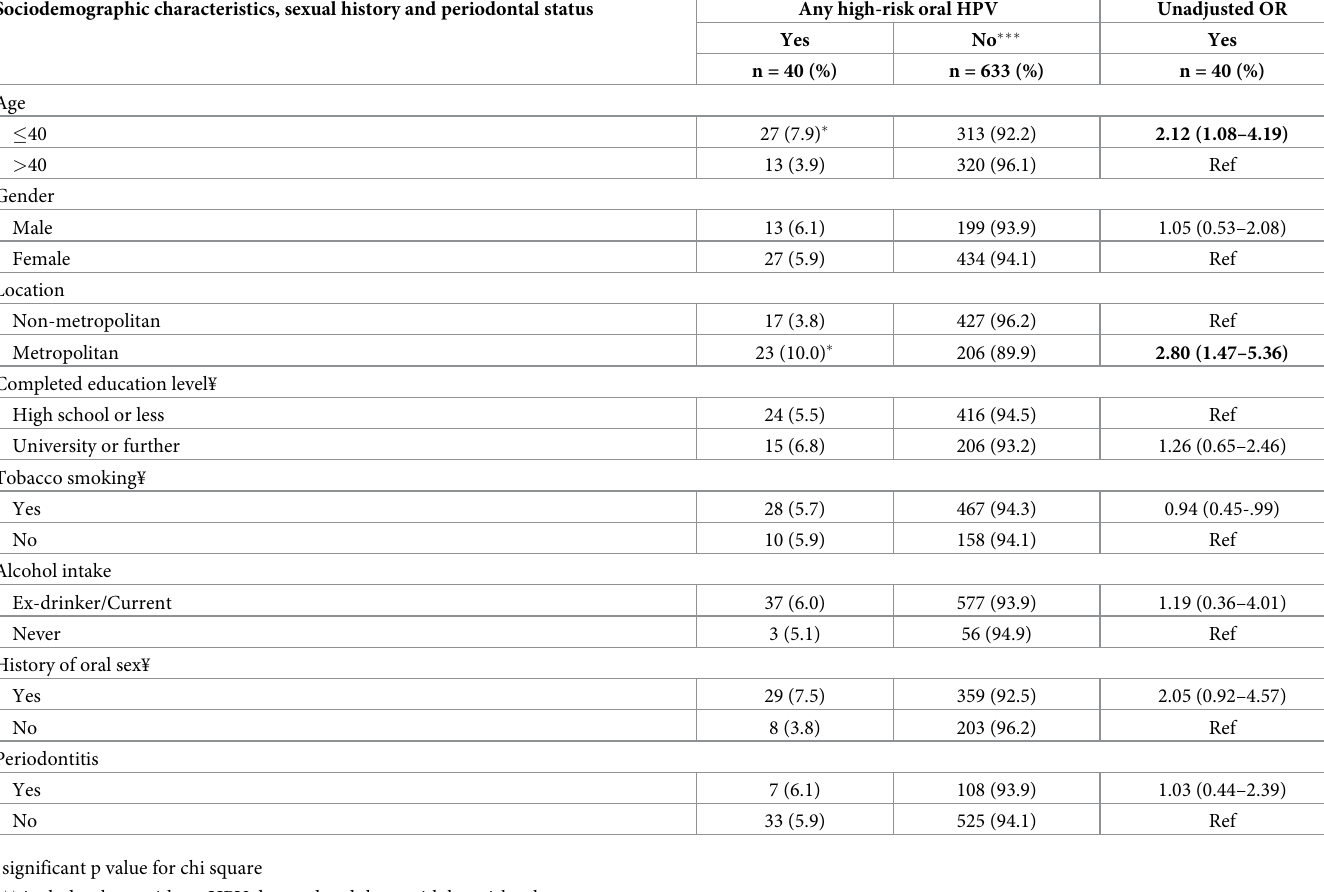
Table 2. Bivariate association between sociodemographic and periodontitis with any high-risk oral HPV (N = 673). Sociodemographic characteristics, sexual history and periodontal